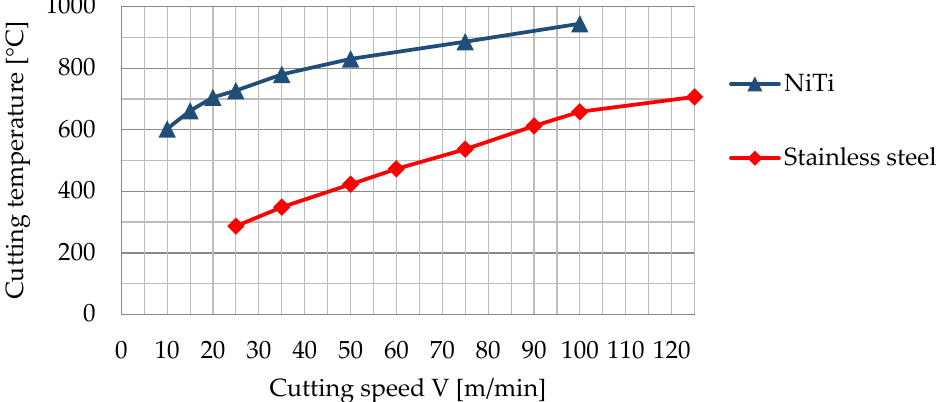
Figure 7. Measured cutting temperature in orthogonal cutting.